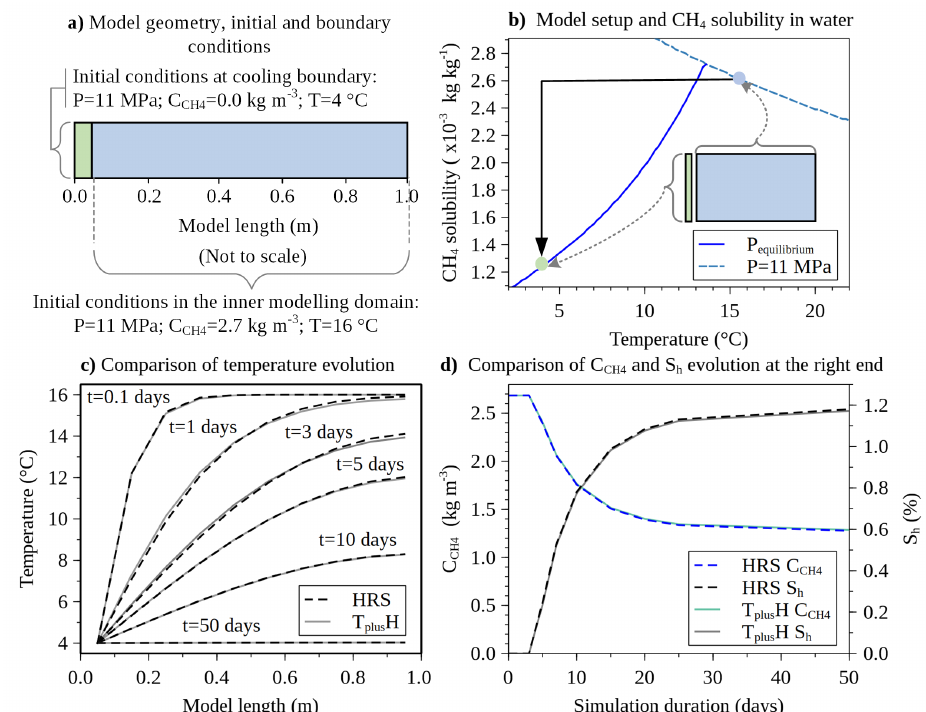
Figure 3. ( a ) The 1D benchmark used for verification of the implemented numerical modelling framework (T plus H); ( b ) curves of CH 4 solubility in water in the presence of hydrate (solid curve, derived from the equilibrium pressure) and without the presence of hydrate (dashed curve, computed by the fixed pressure) [59,60]; ( c ) comparison of temperature distributions along the model length, computed by T plus H and compared against those produced by HydrateResSim (HRS); ( d ) comparison of hydrate saturation (S h ) and CH 4 concentration in fluid (C CH4 ) at the right boundary, computed by T plus H against those produced by